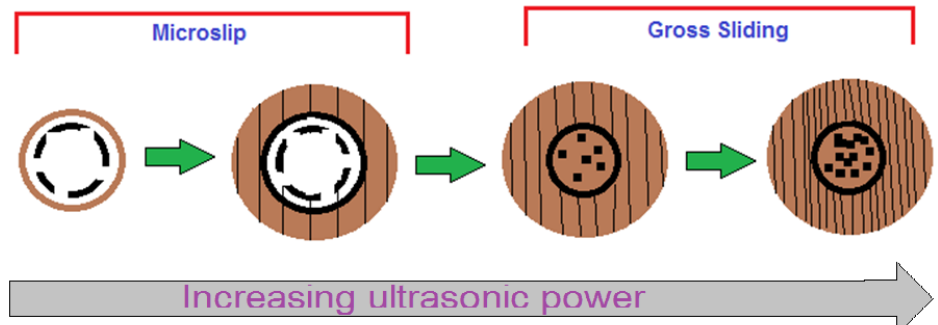
Figure 10. Illustration of ball bonding mechanism. N and S are normal and tangential force, respectively; µ s represents the coe ffi cient of static friction, and a’ and a denote annulus inner radius respectively; μ s represents the coefficient of static friction, and a’ and a denote annulus inner radius and contact radius, and contact radius, respectively.